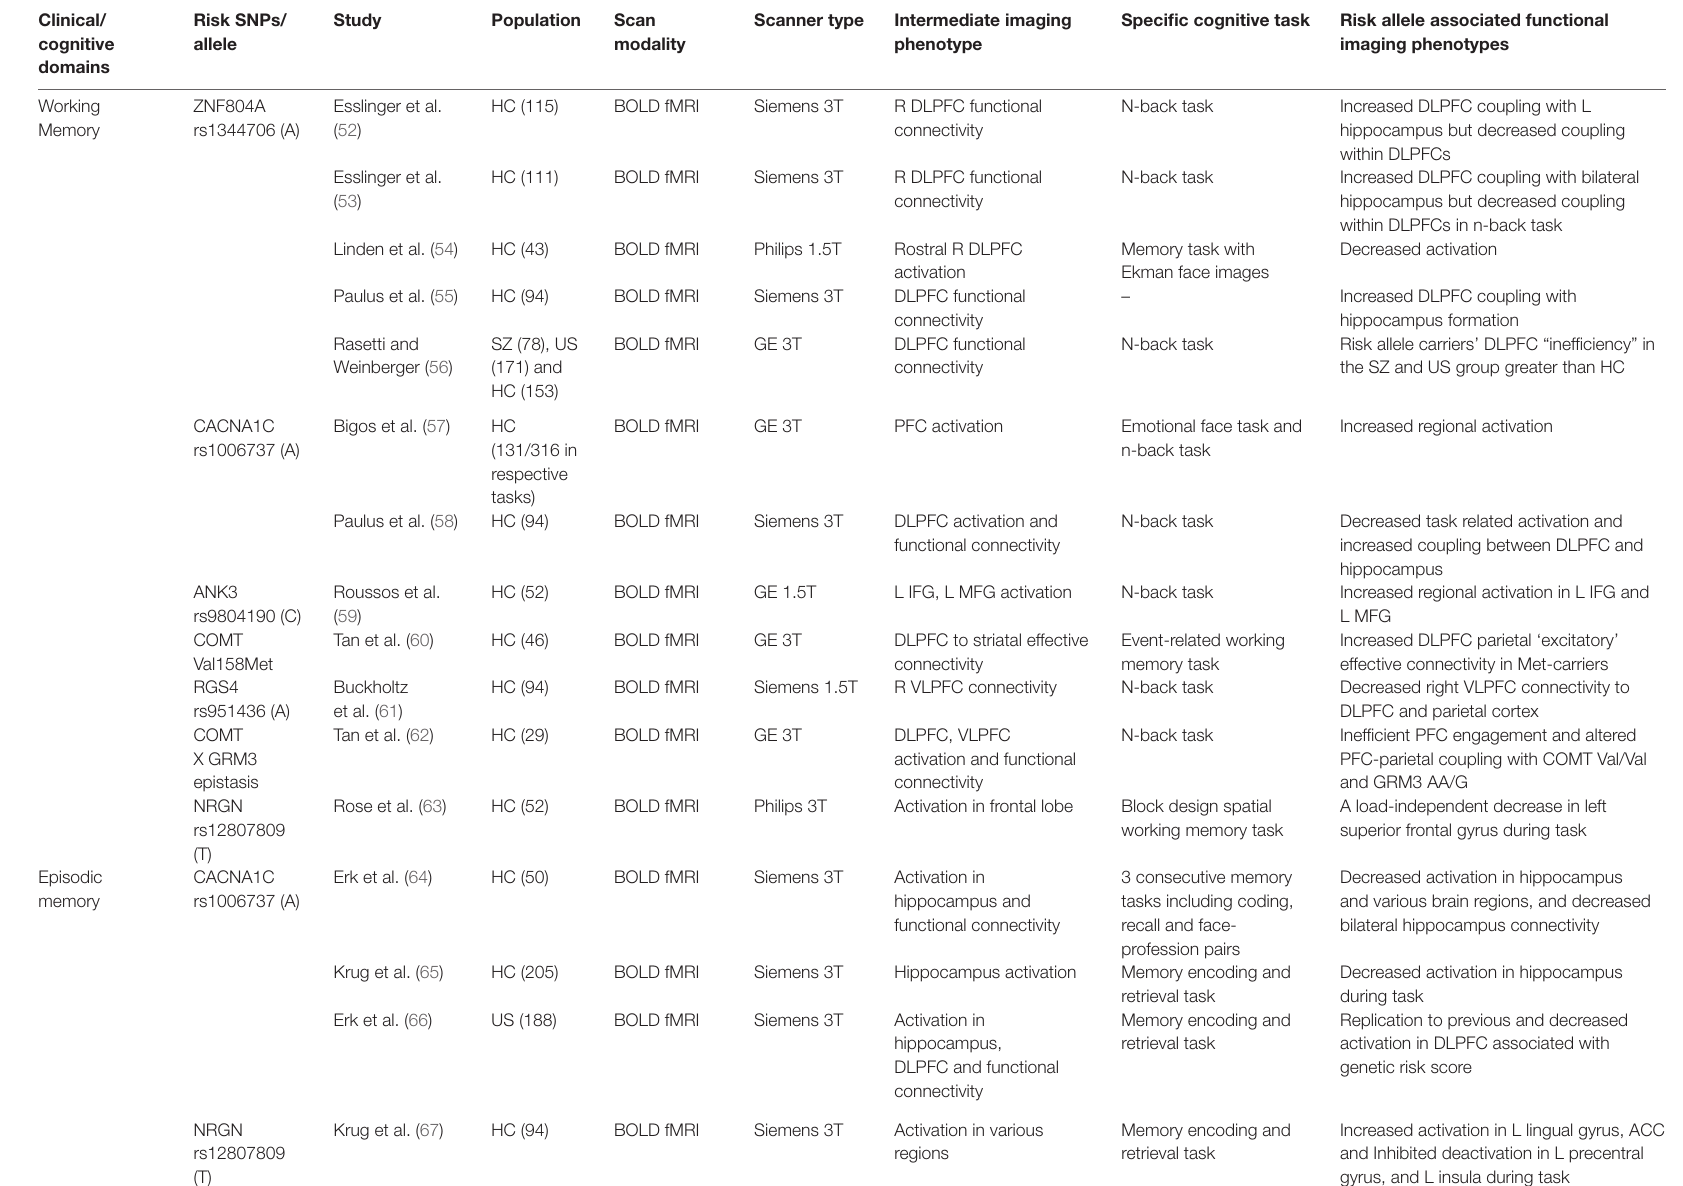
TABLE 1 | Clinical/cognitive domain specific imaging genetic evidence and potential intermediate functional imaging phenotypes. Clinical/